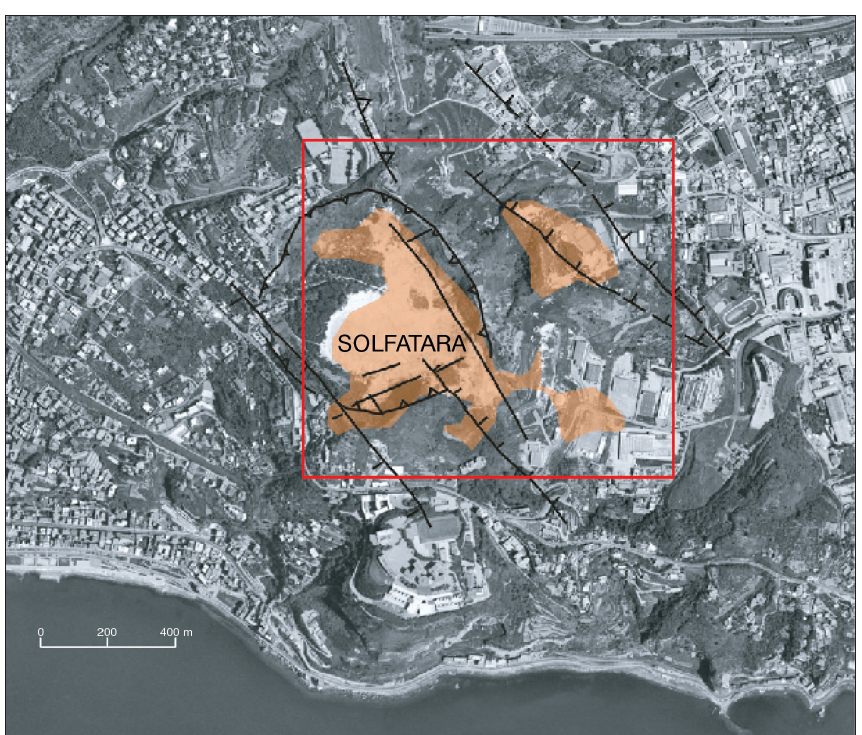
Fig. 1. Planar view of the investigated area around the Solfatara crater, Naples, Italy. Coloured part represents diffuse degassing area; the red rectangle encloses the periodically monitored area.